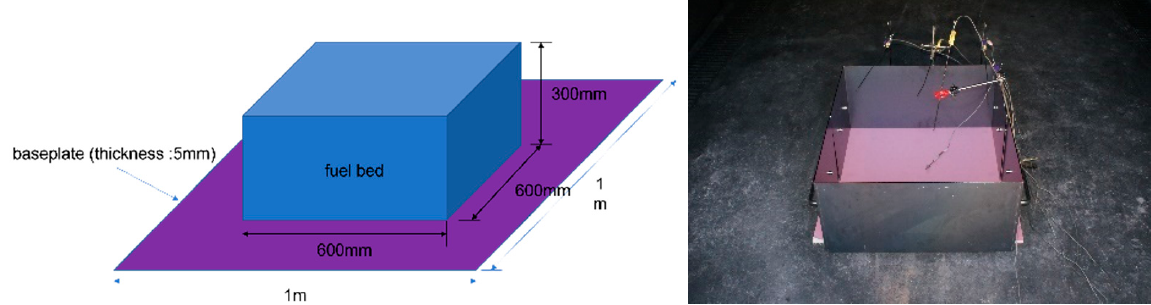
Figure 7. Experimental equipment design and mockup.